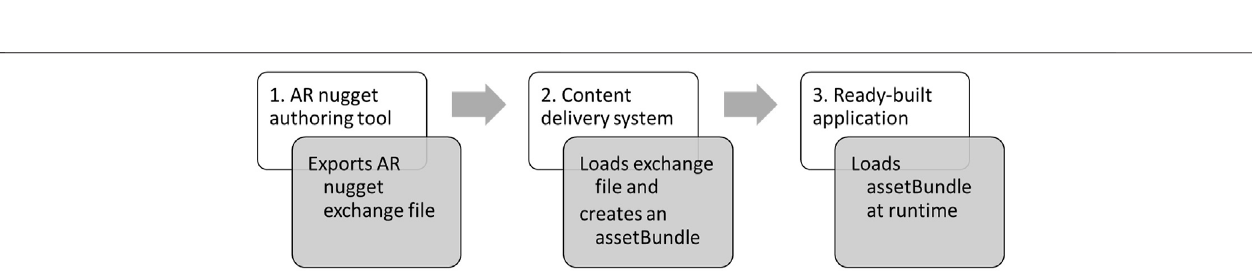
FIGURE 6 | Pictures of a semantic zoom AR nugget that was implemented by a person without programming knowledge using the AR nugget authoring tool. (A) : Screenshot from the desktop device. (B) : Image using the AR device.